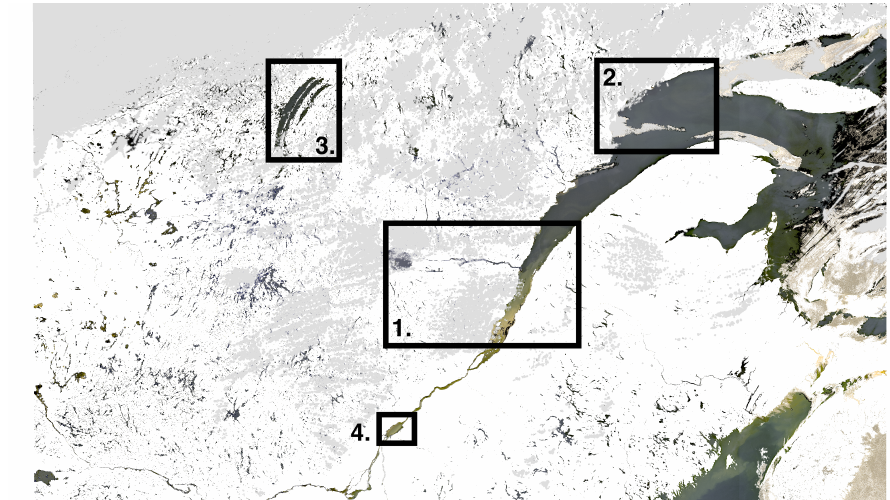
Figure 3. Inland waters in Quebec province. The RGB image was acquired at 8 June 2017 by Sentinel 3 OLCI. Cloud masks are indicated with gray. The four investigated areas are shown in the rectangles.